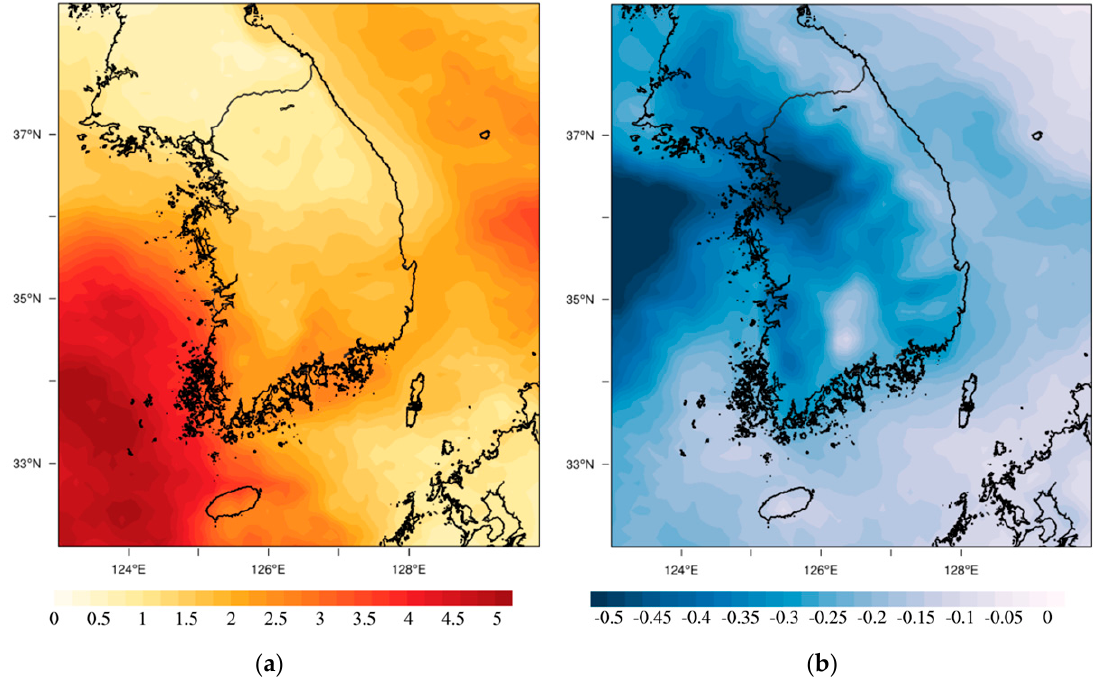
Figure 4. Changes of NO 3 − and NH 4+ concentrations ( μ gm − 3 ) in South Korea due to the reduction of overseas SO 2 emissions (R_FSO2–BASE). ( a ) NO 3 − , ( b ) NH 4+ .